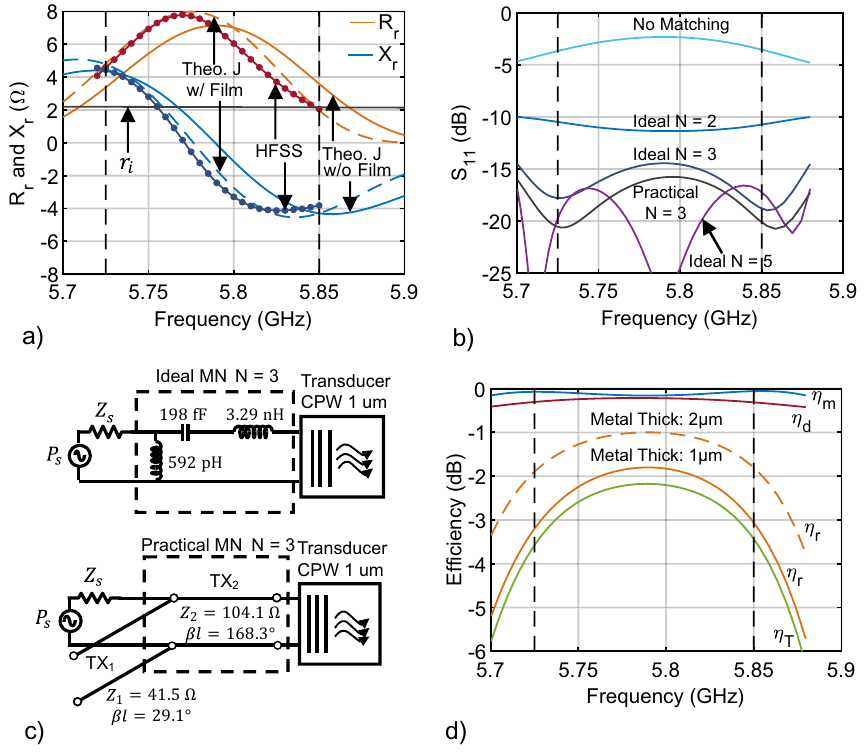
Figure 2. Summary of system performance for a CPW transducer targeting the LTE-U band. ( a ) Radiation impedance for a 100 µ m long CPW transducer (a = 1 µ m) targeting the LTE-U band. The out-of-plane applied bias field is 0.3763 T. Solid orange and blue curves are the radiation resistance ( R r ) and reactance ( X r ), respectively, obtained from the theoretical approach. Markered red and dark blue lines are the radiation impedance obtained from the second approach. Dashed orange and blue lines represent with theoretical radiation impedance computed by modifying step 3 of the theoretical approach. ( b ) Simulated Ŵ L and Ŵ IN with lumped-component MNs of various orders. ( c ) Lumped circuit-model of N = 3 MN and its physical realization using a CPW short-circuited stub and line. Network dimensions are given in Table 1. ( d ) The radiation efficiency ( η r ) for two CPW metal thicknesses, match efficiency ( η m ) and dissipation efficiency ( η d ) using the physical CPW network in ( c ), and overall transducer efficiency ( η T